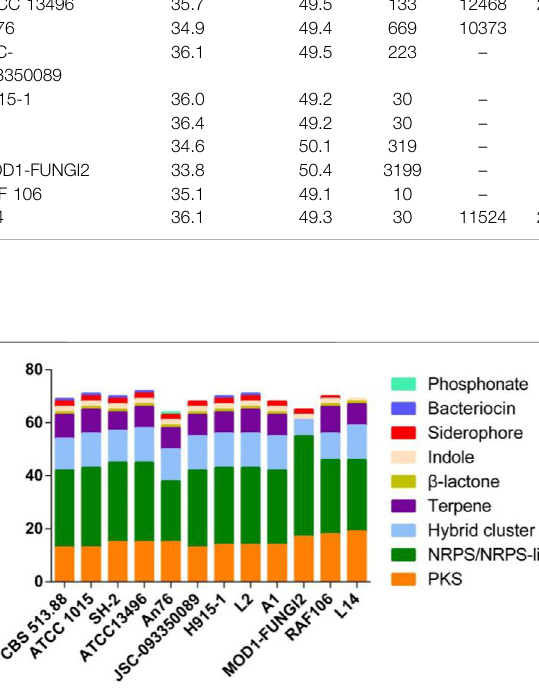
FIGURE2| Biosyntheticgeneclustersofsecondarymetabolitesof12 A. niger